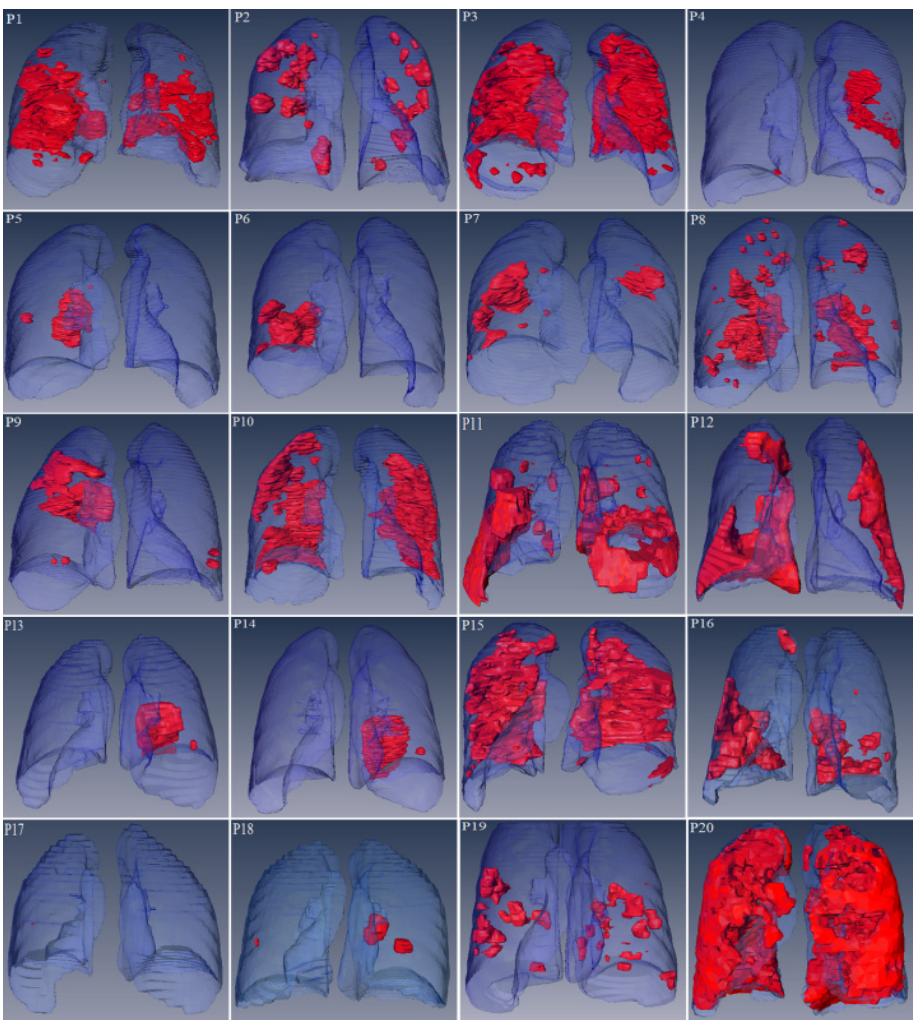
Figure 7. Volume reconstruction of the lungs and its corresponding infection regions of the twenty patients.